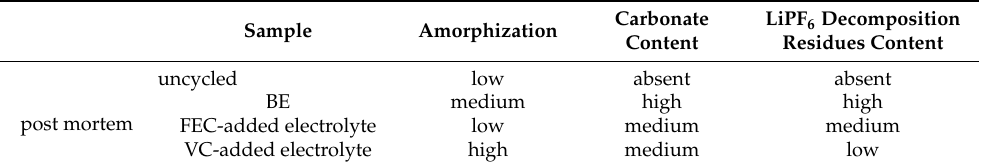
Table 3. Summary of the most relevant experimental features obtained from the multi-spectroscopy analysis on the Si NW electrodes collected after 5 galvanostatic